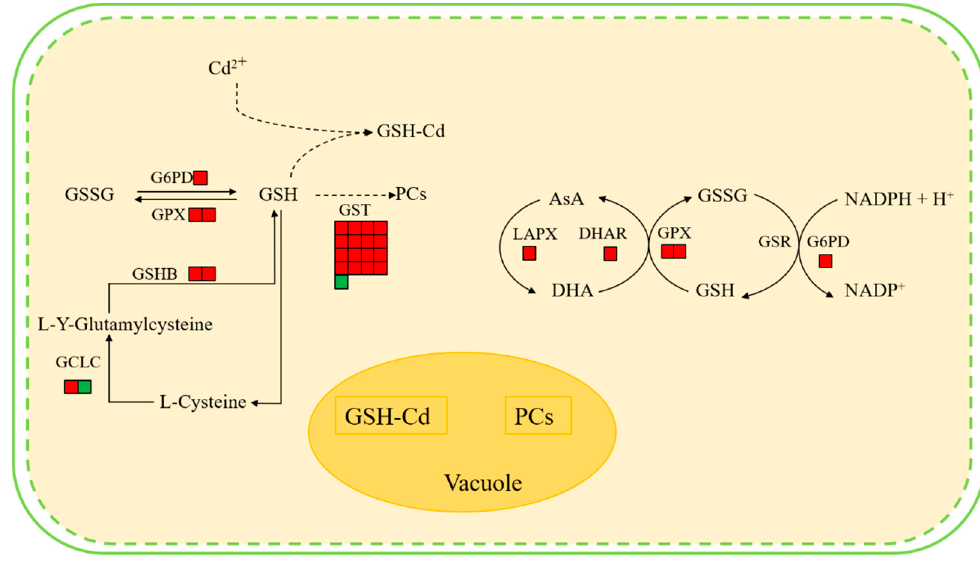
Figure 7. Main changes in Brassica campestris L. metabolism after Cd exposure. Red boxes indicate an increased abundance in Cd-treated plants compared with controls, and green boxes indicate a reduced abundance in Cd-treated plants compared with controls. Abbreviations: GSHB, glutamine synthase; GSH, glutathione; GSSG, oxidized glutathione; GST, glutathione- S -transferase; GPX, glutathione peroxidase; GCLC, glutamate-cysteine ligase catalytic subunit; GSH-Cd, glutathione-cadmium complex; PCs, phytochelatins; AsA, ascorbate; MDH, malate dehydrogenase; MDHA, monodehydroascorbate; LAPX, l -ascorbate peroxidase; G6PD, glucose-6-phosphate 1-dehydrogenase; GSR, glutathione reductase.